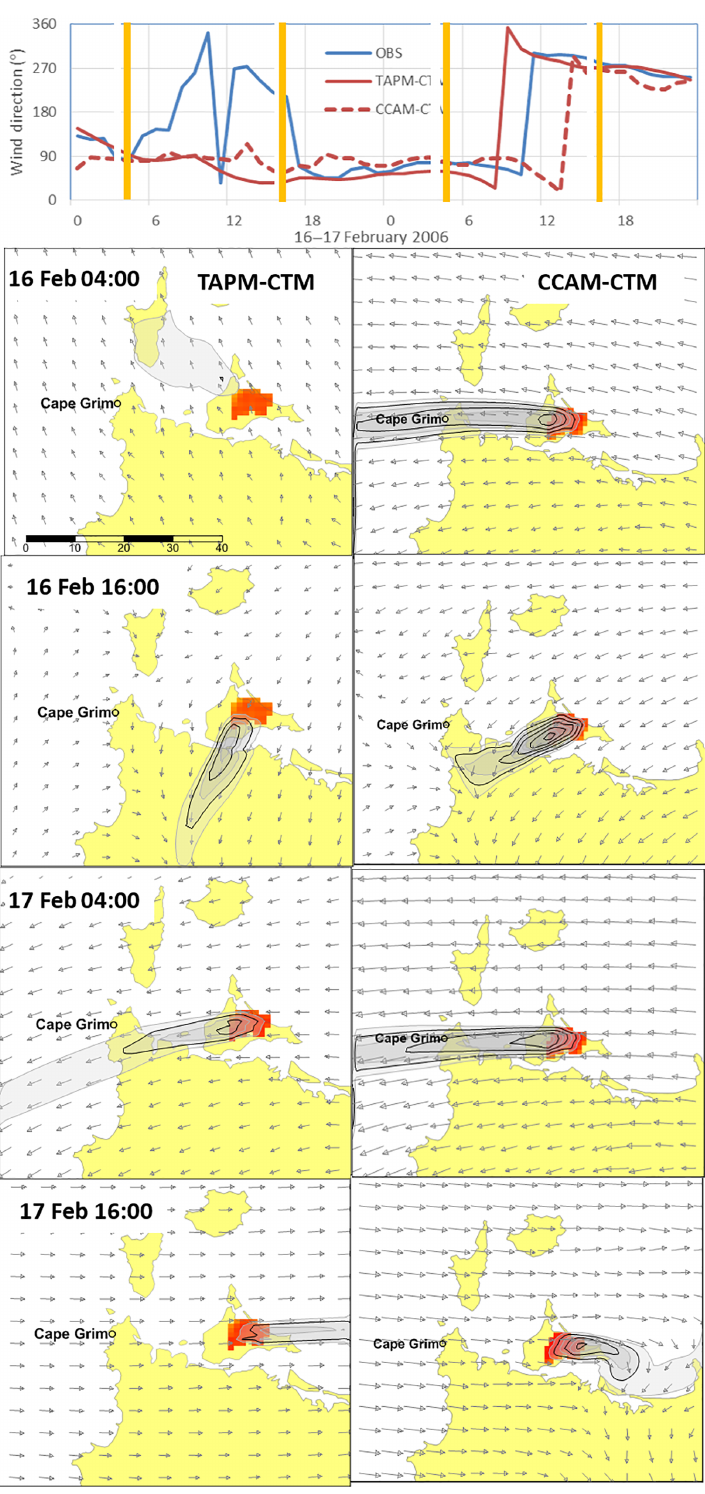
Figure 4. Model concentration isopleth of BC for TAPM–CTM (left panels) and CCAM–CTM (right panels). Panels show 12h time intervals during BB1, including the BB plume intermittently striking Cape Grim, followed by the change in plume direction with wind direction change. Arrows are wind vectors. The time series of observed and modelled wind direction for BB1 are shown above with golden bands highlighting the periods corresponding to the